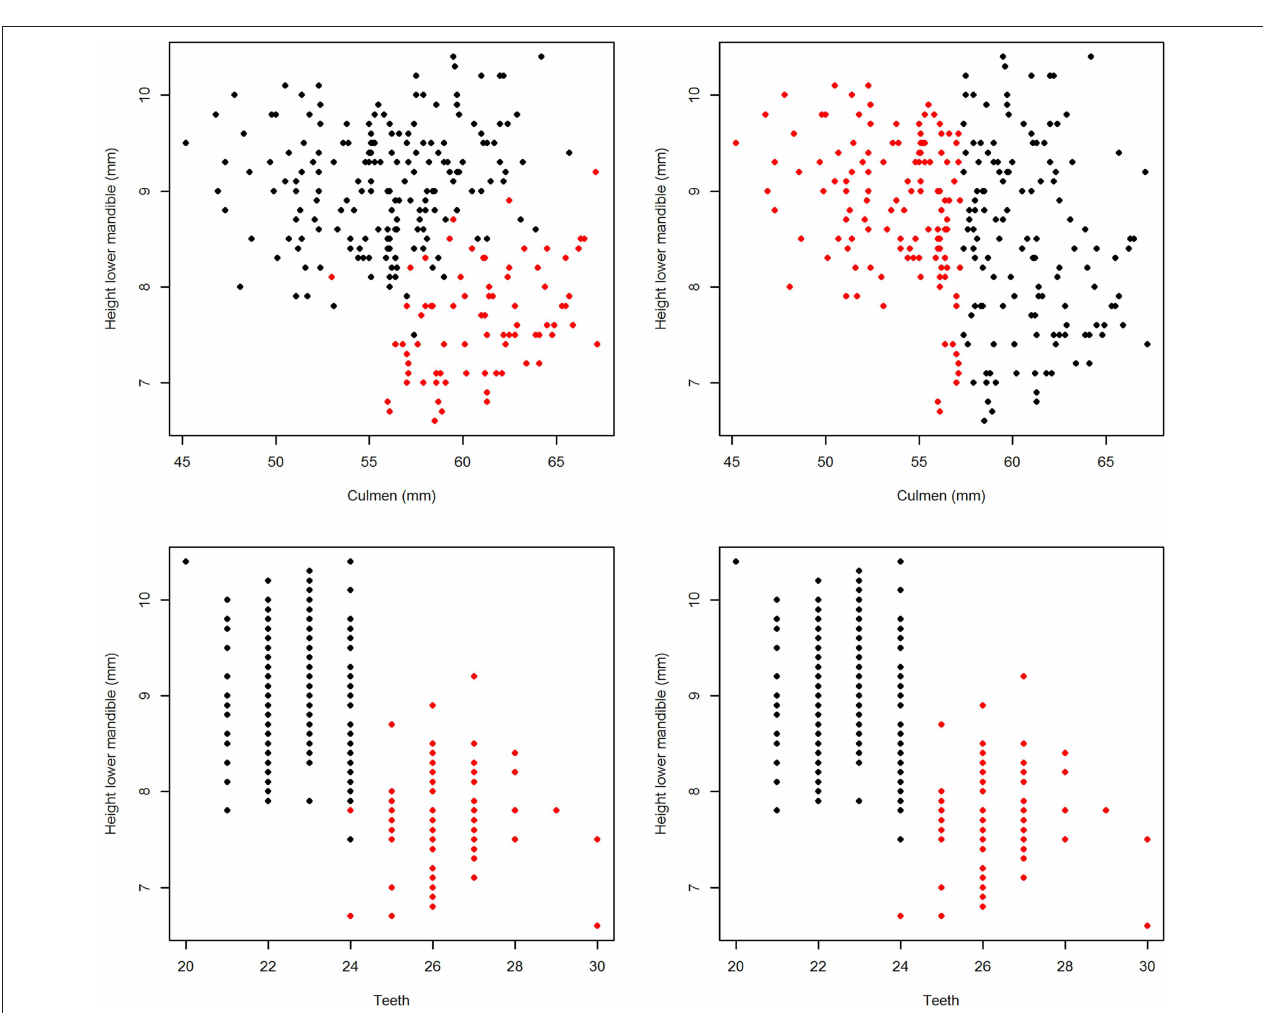
FIGURE 5 | Plots of individual Bean Geese ( fabalis = red, rossicus = black) on pairs of variables. (Left) original subspecies classification (ground truth). (Right) classification by the “kmeans”